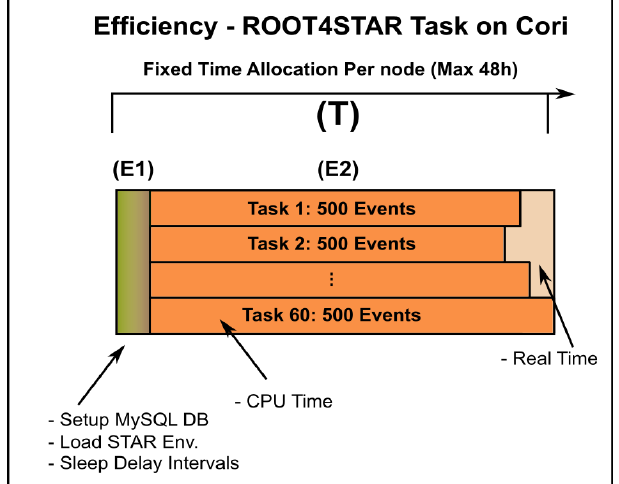
Figure 4. Illustration describing total efficiency of R4S tasks on Cori. The green/brown portion on the left is the “Job Start Efficiency” which is composed of the MySQL DB setup, loading of the STAR software environment, and sleep delay intervals. The middle portion is the CPU/Real time “Event Efficiency” . The right most portion on the right is idle CPU time after a task has finished earlier than